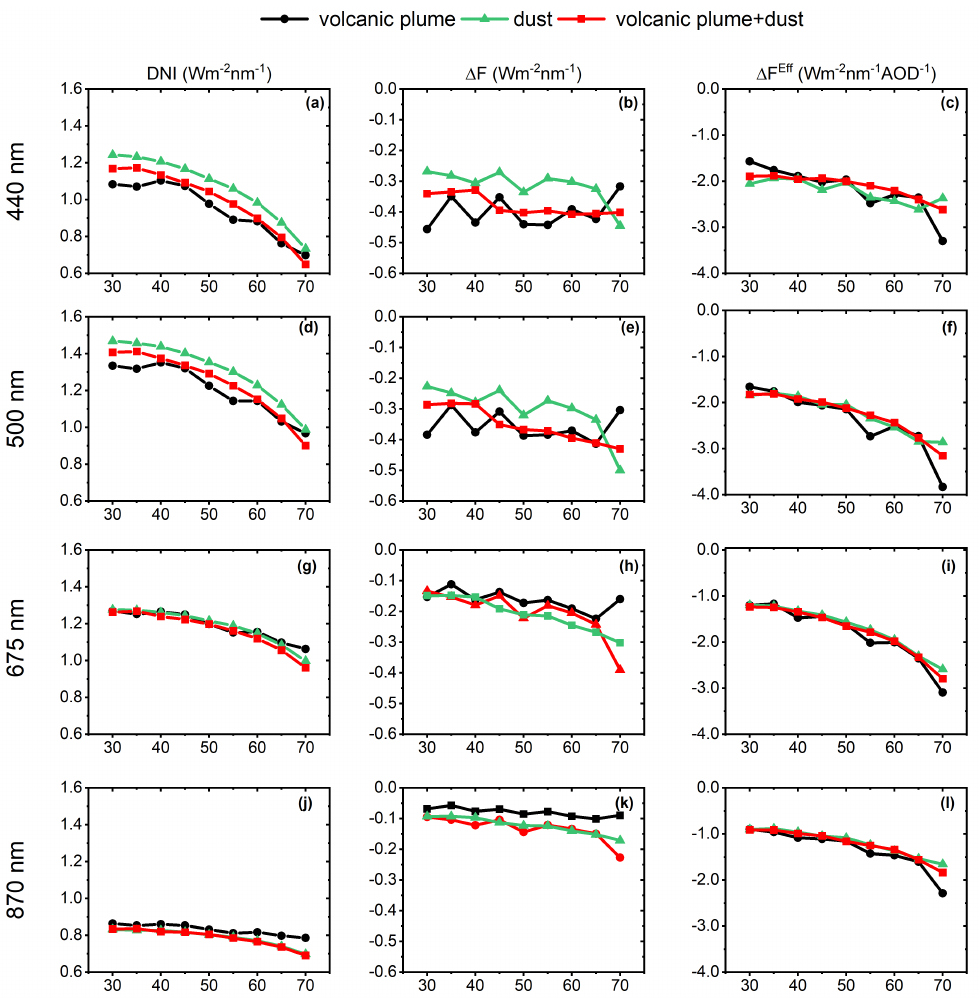
Figure 9. Spectral direct normal irradiance (DNI, Wm − 2 nm − 1 ) ( a , d , g , j ), aerosol direct radia- tive forcing ( ∆ F , Wm − 2 nm − 1 ) ( b , e , h , k ), and aerosol direct radiative forcing efficiency ( ∆ F Ef f , Wm − 2 nm − 1 AOD − 1 ) ( c , f , i , l ) at 440, 500, 675, and 870 nm, respectively, as a function of the SZA ( ◦ ) for the three case studies at the IZO: volcanic plume (black), dust (green), and volcanic plume + dust